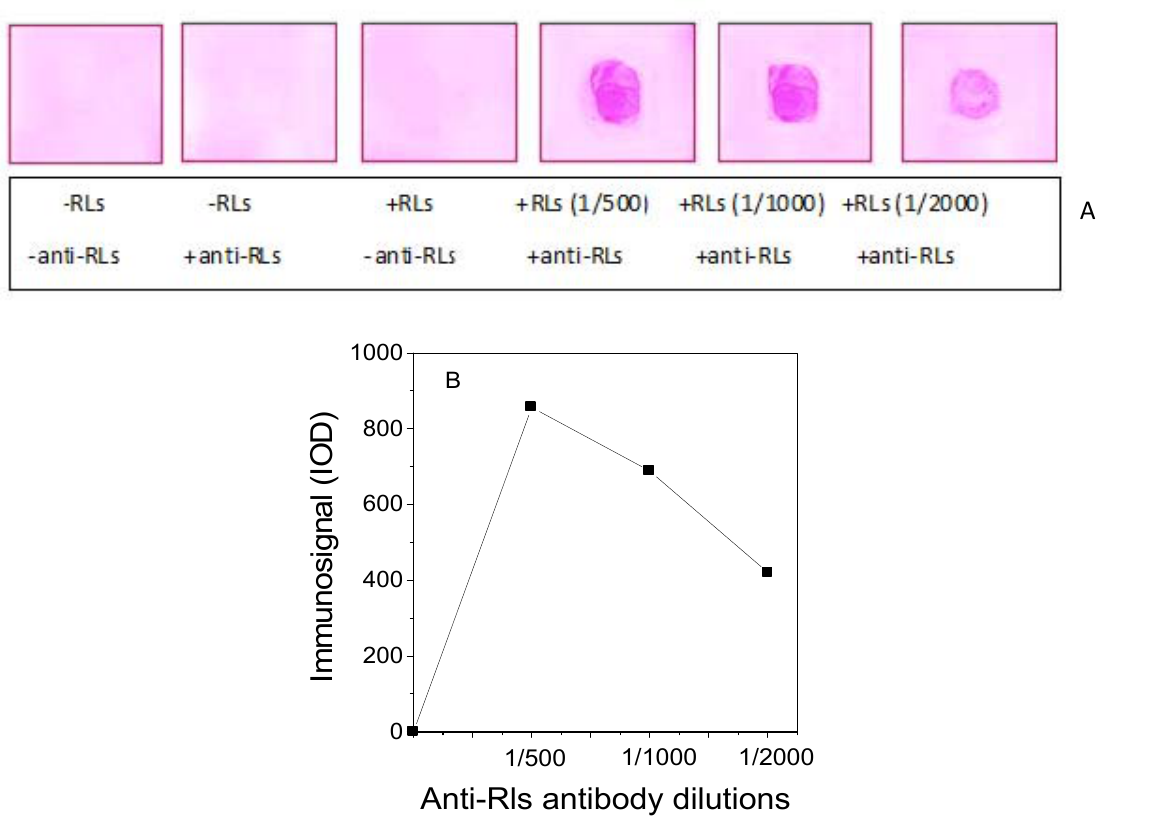
Figure 3. Immuno-dot blot assay performed by spotting Tth RLs (50 μ g), purified from the extracellular medium of a T. thermophilus culture in the presence of sodium gluconate as sole carbon source, and then the membranes were probed with different dilutions (1/500, 1/1,000 and 1/2,000) of rabbit polyclonal antiserum against Tth RLs ( A ). Quantification of the intensity of immune-staining by the Gelpro Analyzer V.3 computer program was performed, and a curve of the immunosignal as function of anti-RLs antibody dilutions was